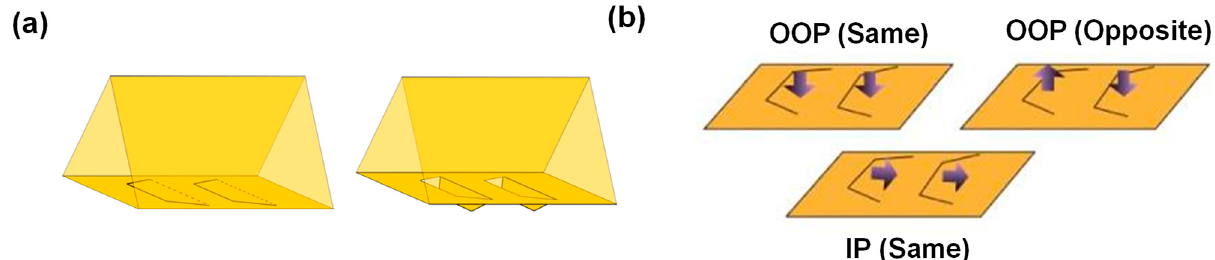
Figure 1. Proof of concept to verify locomotion mechanism design. ( a ) Design of triangular prism mechanism where the bases consist of trapezoid-shaped magnetic flaps that rotate out of the plane for locomotion. ( left ) Triangular prism mechanism in neutral position; ( right ) triangular prism mechanism in popped-up (actuated) position. ( b ) Different magnetization directions: OOP magnetization (same direction placement), OOP magnetization (opposite direction placement) and IP magnetization (same direction placement).